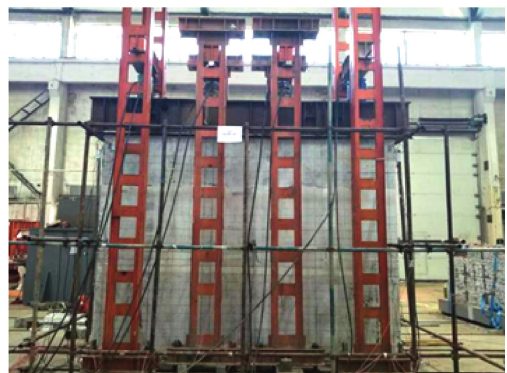
Figure 4: The loading device of the compressive